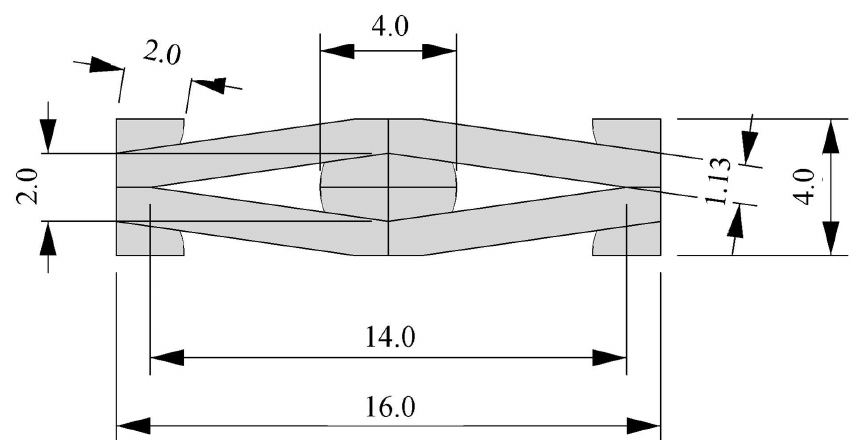
Fig 2. Swelling-honeycombs model. Diamond-shaped honeycombs inspired by the microstructure of the ice plant keel’s tissue. The unit cell has a diamondshape with a width-to-height ratio of 4 for stiff walls (1.13 mm thickness) and round soft inclusions. The honeycombs were built as rectangulararrays of 5-by-10 cells. All dimensionsare in